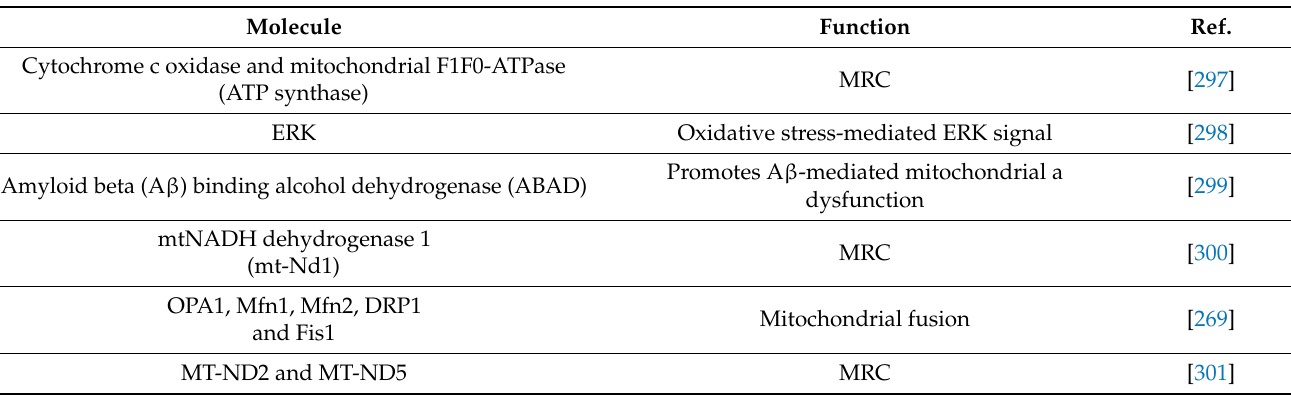
Table 4. Proteins involved in mitochondrial dysfunction in Alzheimer’s disease.